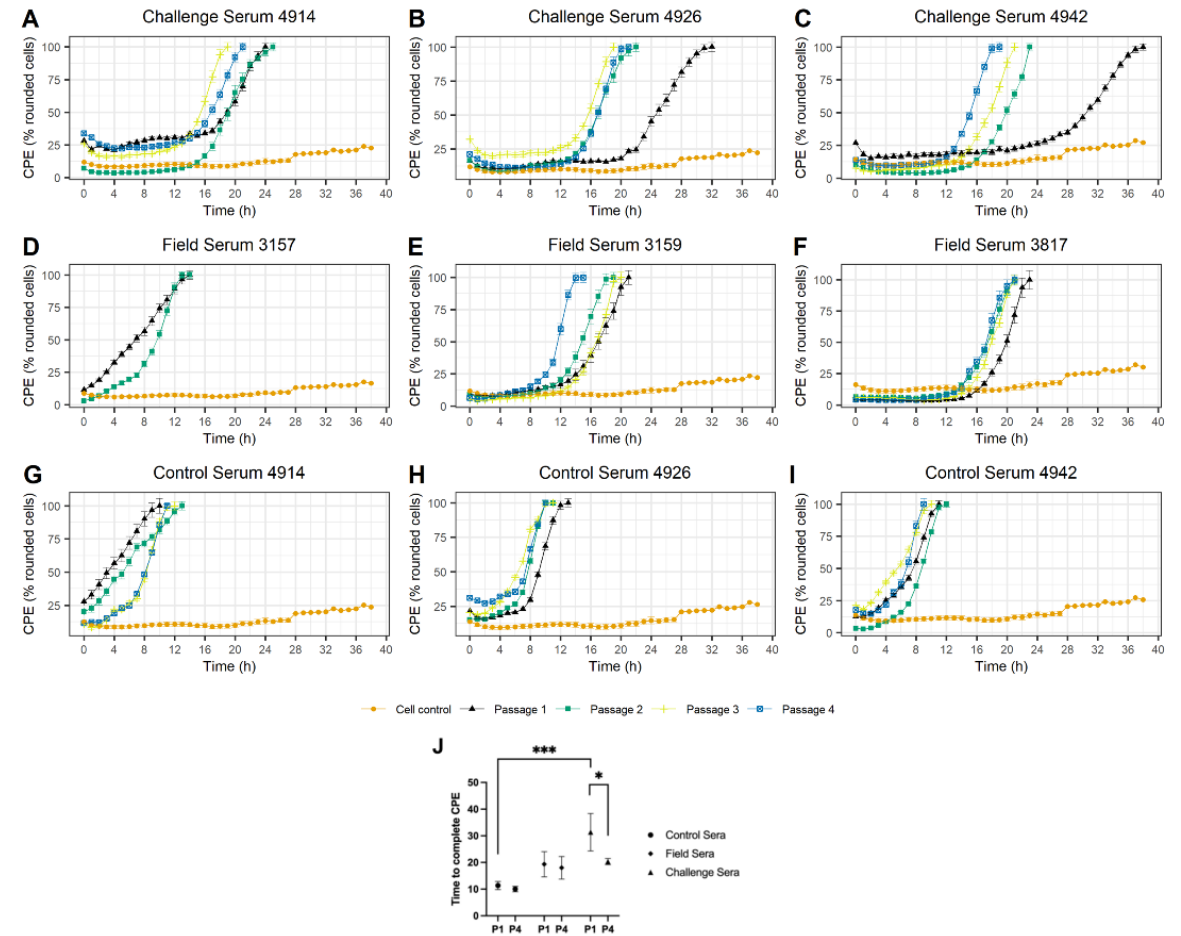
Figure 2. Killing curves measuring the percentage CPE (i.e., rounded cells) induced by the IRN/22/2015 isolate grown in the presence of sub-neutralising levels of sera from the Challenge group ( A – C ), Field group ( D – F ) or Control group ( G – I ). Each curve (black, green, yellow or blue) represents a single passage (P1, P2, P3 or P4, respectively). LFBK- α V β 6 only controls are shown in orange. Error bars represent the SEM calculated based on six replicates. Statistical comparison of time to CPE upon the initial and the final passages of the virus in presence of sera from Control, Field, and Challenge group ( J ). Markers represent mean and bars represent SEM. Statistical significance was indicated: * p < 0.05, *** p < 0.001.